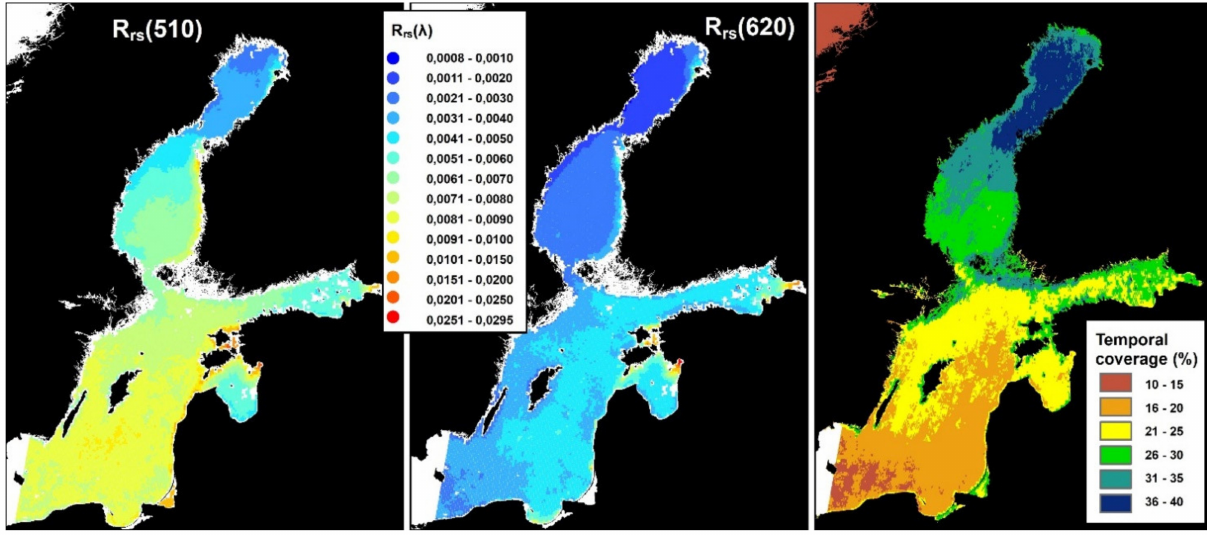
Figure 2. The mean of the normalized reflectance R rs ( λ ) over the years 2004–2011 during the open water period 1 June–15 September. Temporal coverage of the observations of the time series during the same period